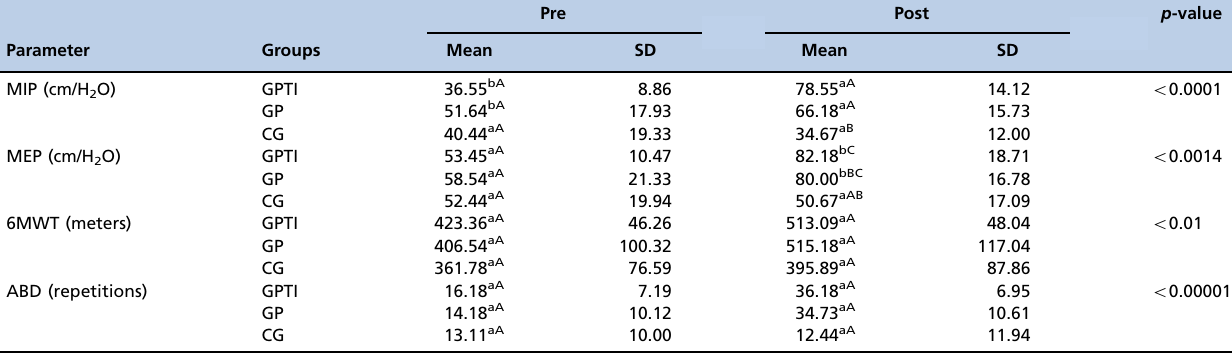
Table 1 - Pre- and post-intervention pulmonary function comparisons between the GPTI (n=11), the GP (n=11) and the CG (n=9). Pre Post Parameter Groups